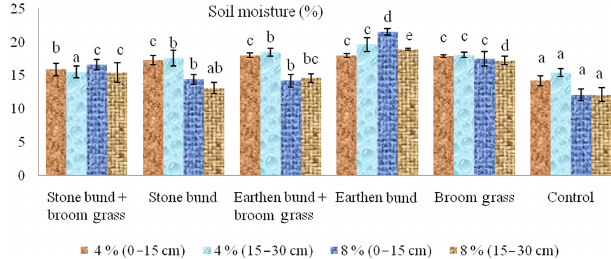
Figure 2. Impact of grasses in reducing runoff in lateritic soil.